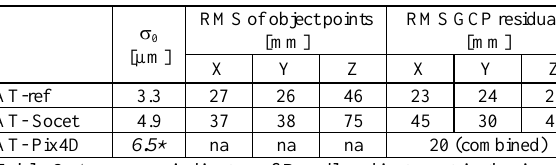
Table 2: Accuracy indicator of Bundle adjustment in the image space ( σ ) and in the object space. 0